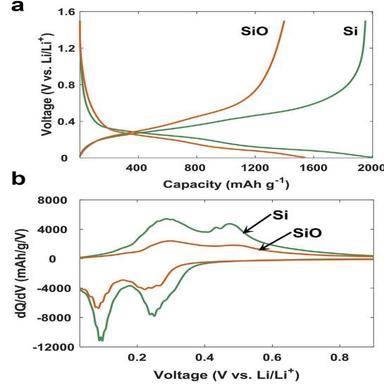
(a) The galvanostatic discharge-charge voltage profiles and (b) the differential-capacity plots of Si and SiO anodes.